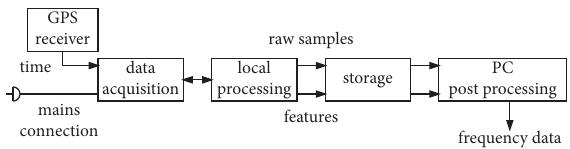
Figure 7: Conceptual illustration of the data acquisition and processing chain. Data are acquired, processed, and stored on the electrical data recorder device. Both raw samples and processed data are available for in-depth analysis on a PC. Te EDR also supports remote data storage, live monitoring, and current mea- surements, which are not depicted here. See [18, 45, 46] for details.